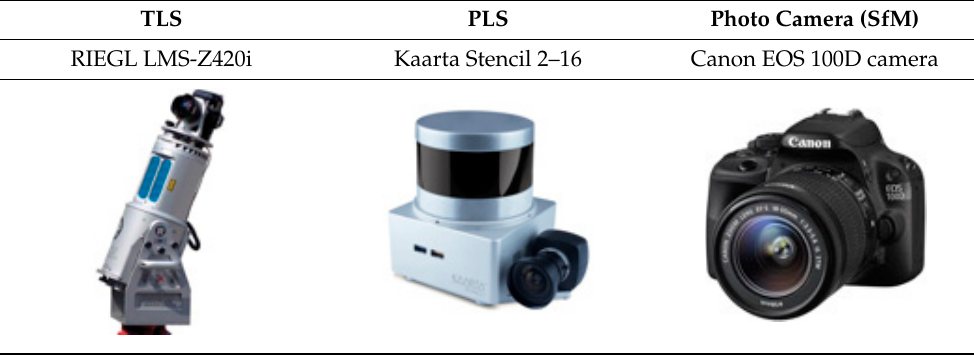
Table 1. Adopted instrumentation for the acquisition of the 3D model of the test site.